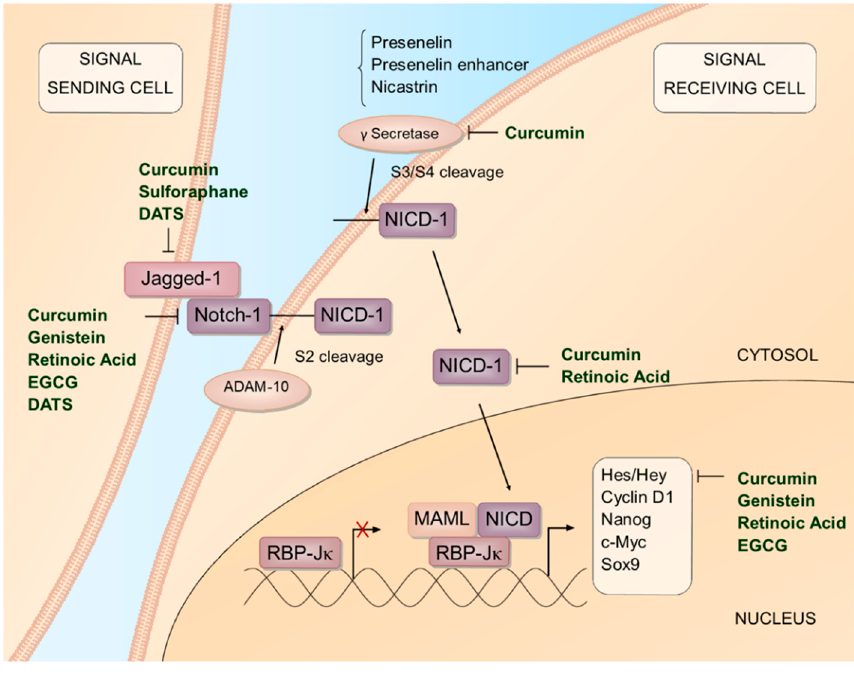
Figure 1. Effect of dietary agents on Notch signaling pathway in cancer cells. Notch ligands, including Jagged-1, bind to, and permit cleavage of, the Notch receptor. The Notch extracellular domain is first cleaved by ADAM-10; Notch intracellular domain (NICD) is then cleaved by the gamma secretase complex. NICD translocates and activates transcription in the nucleus. Dietary agents that modulate Notch in cancer cells in vitro are listed. EGCG, epigallocatechin-3-gallate; DATS, diallyl trisulfide; RBP-J κ , recombinant signal binding protein for immunoglobulin kappa J region; MAML, mastermind-like